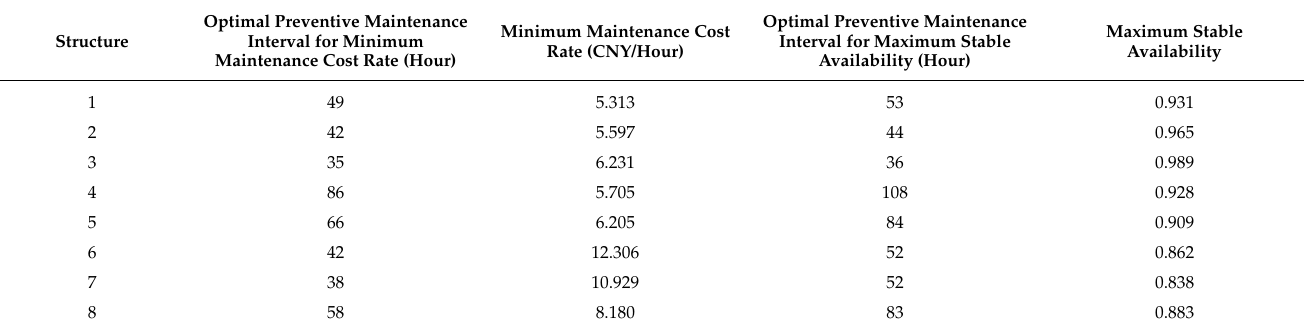
Table 2. Optimal maintenance intervals for minimum maintenance cost rate and maximum